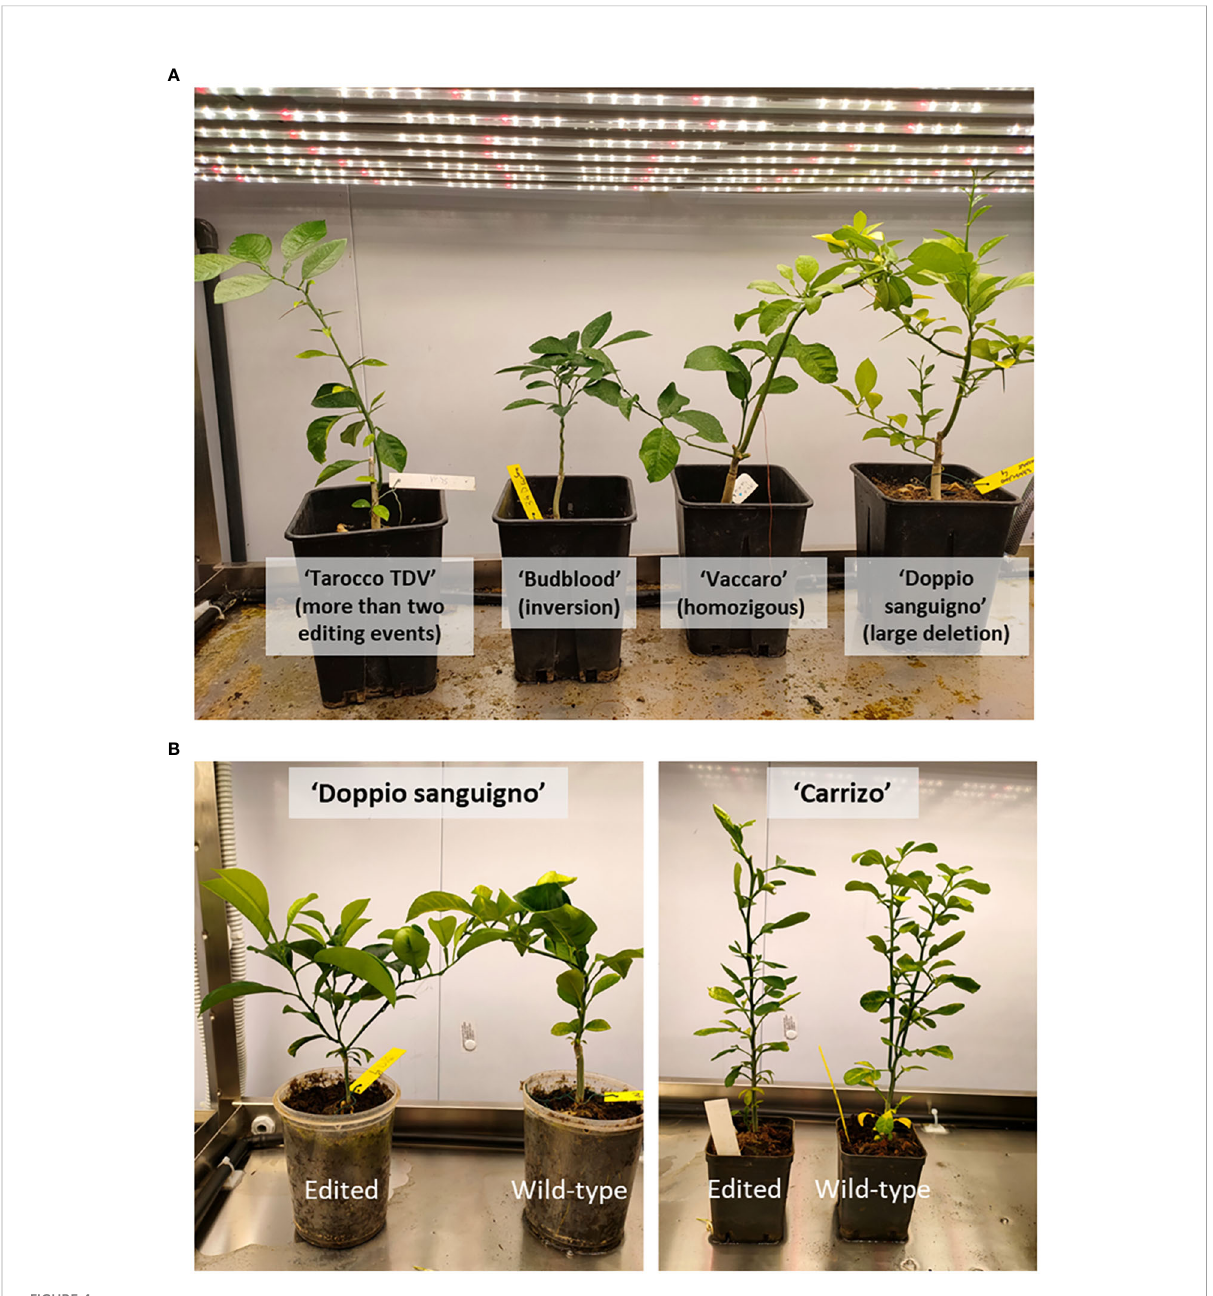
FIGURE 4 Citrus plantlets edited with the b -LCY2 gene. (A) Four editing events in four anthocyanin-rich varieties. Differences in the shapes of plantlets are independent of the mutation type. (B) Edited ‘ Doppio Sanguigno ’ and ‘ Carrizo ’ plantlets and related wild type. No differences in the phenotype are